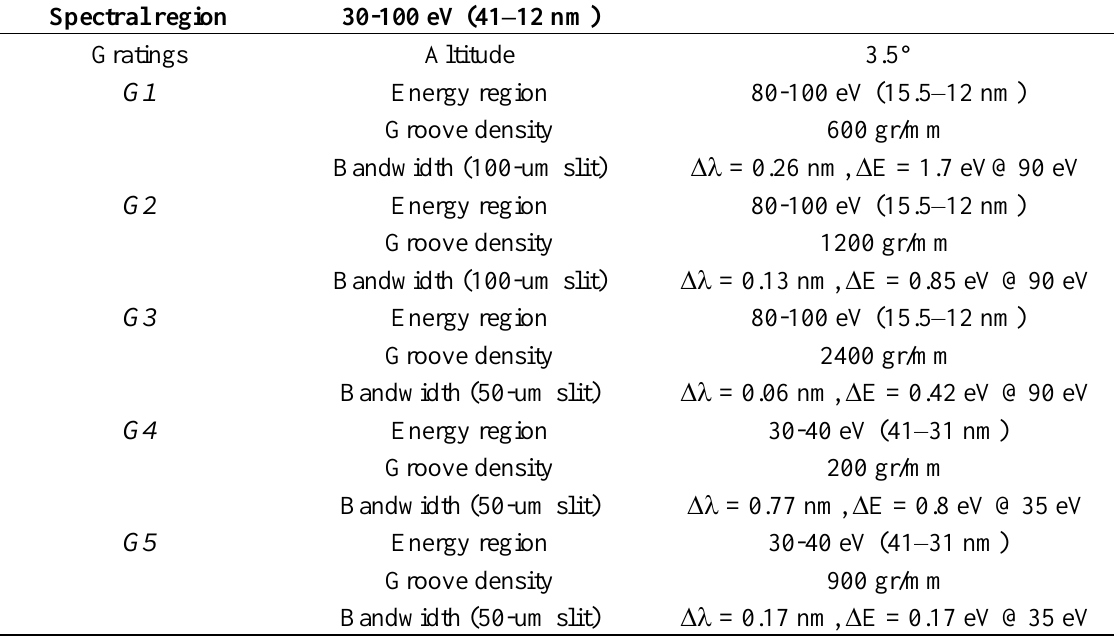
Table 1. Parameters of the OPM monochromator developed for LSU-EPFL HH beamline.